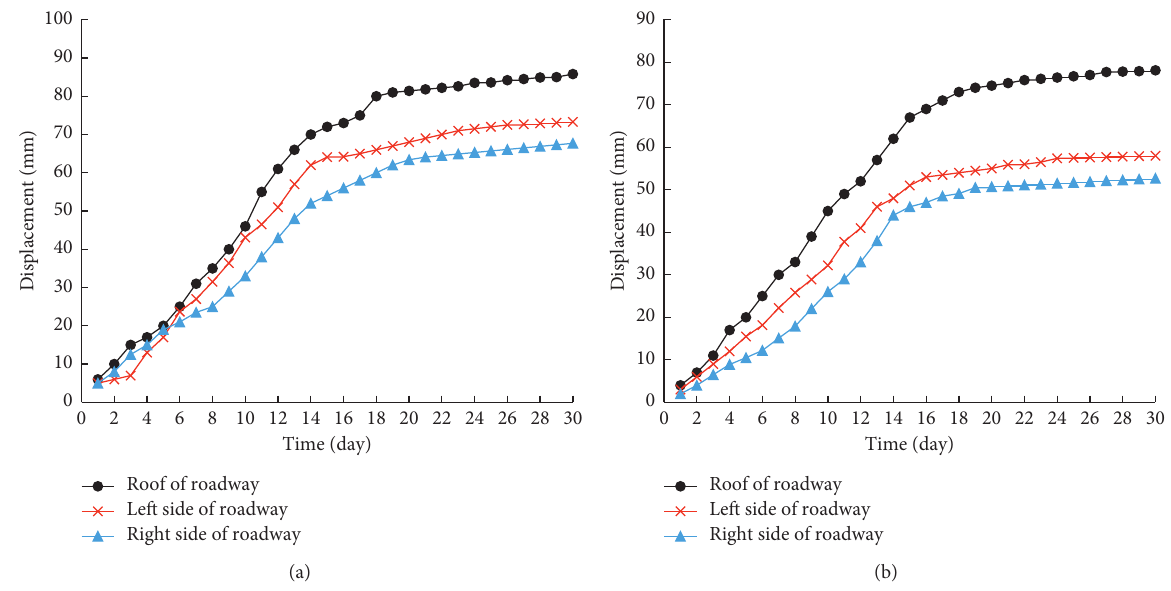
Figure 10: Observation results of roadway Surface displacement. (a) The first measuring point. (b) The second measuring